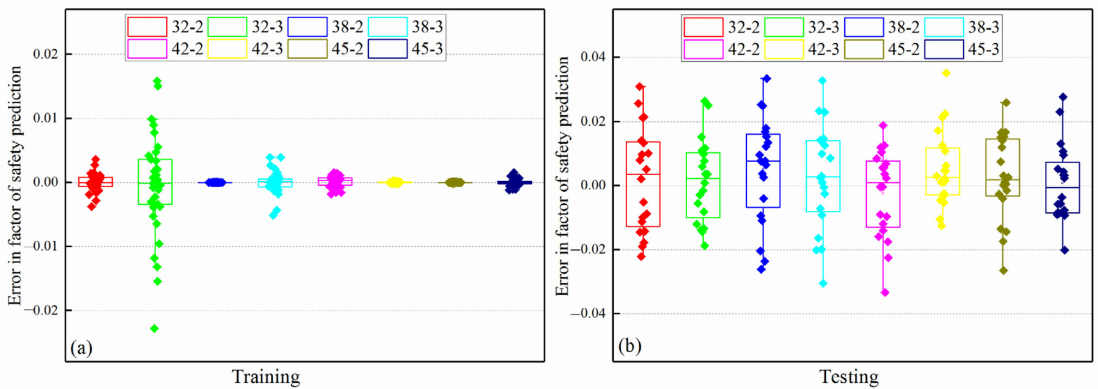
Figure 5. The error in factor of safety prediction obtained from WOA-GPR with different samples and cycles (here 32-2 denotes two cycles with 32 samples): ( a ) Training; ( b ) testing.